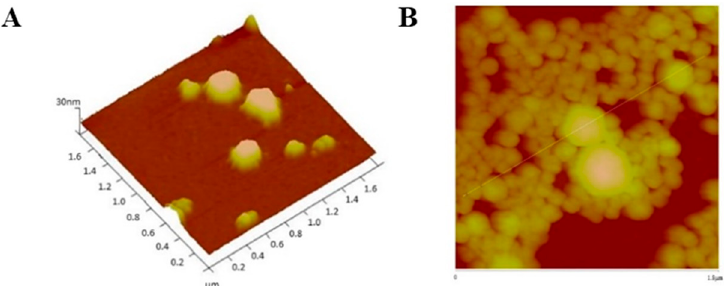
Figure 8. AFM images (3D and 2D images) with size scale of ( A ) PvD-loaded, and ( B ) empty ERL conjugated NPs.